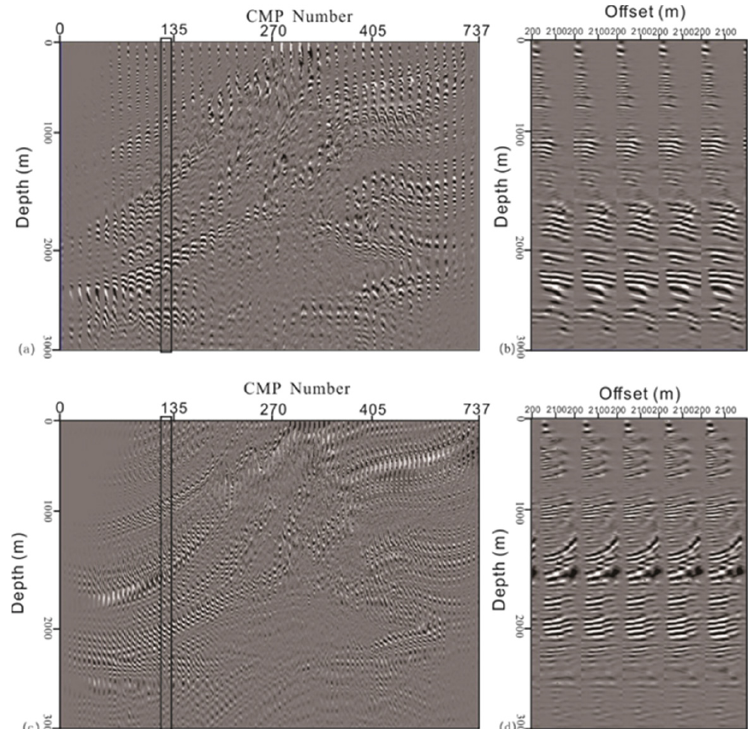
Figure 4. Imaging profiles and gathers at the velocity increased ( a ) and the enlarged display of partial gathers ( b ) decreased by 5% ( c ), and ( d ) enlarged display of partial gathers ( d ).